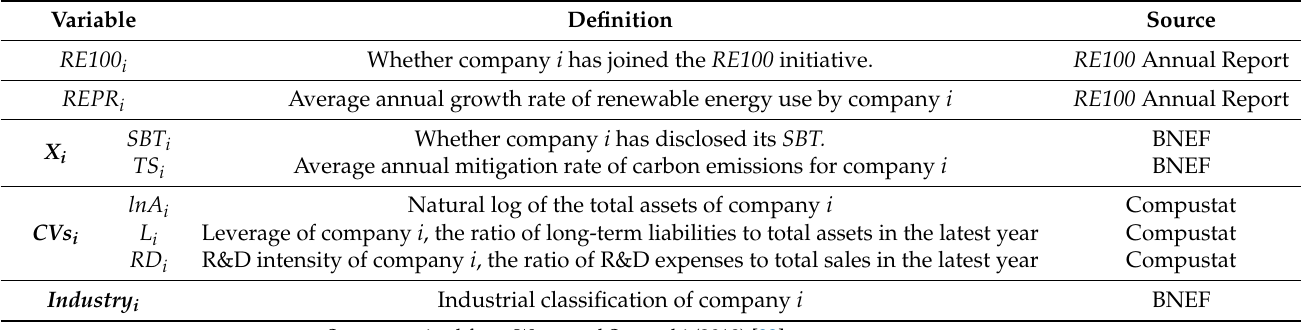
Table 1. Variable definitions and data